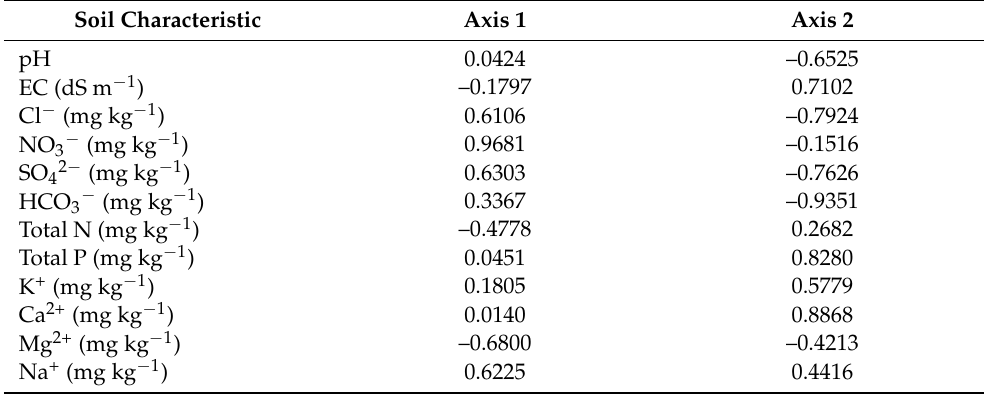
Table 3. Mean (±standard error, n = 6) inorganic nutrient contents of Taif Rose populations grown in four farms in the mountainous area of Taif City in Saudi Arabia.